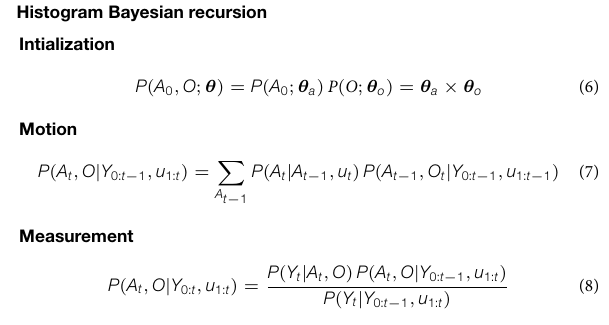
Figure 4 ( Bottom left ) illustrates the likelihood function